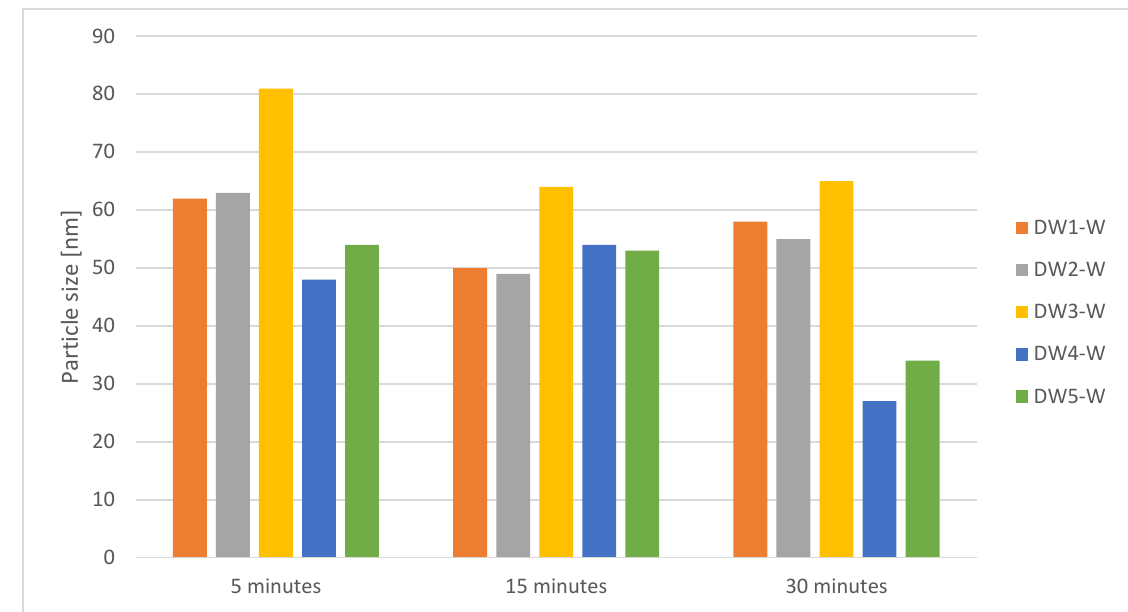
Figure 8. Results of particle size measurements in DW(1-5)-W drilling waste water extract samples with AgNPs (60 nm). Results for three different centrifugation times such as 5, 15, and 30 min are shown.